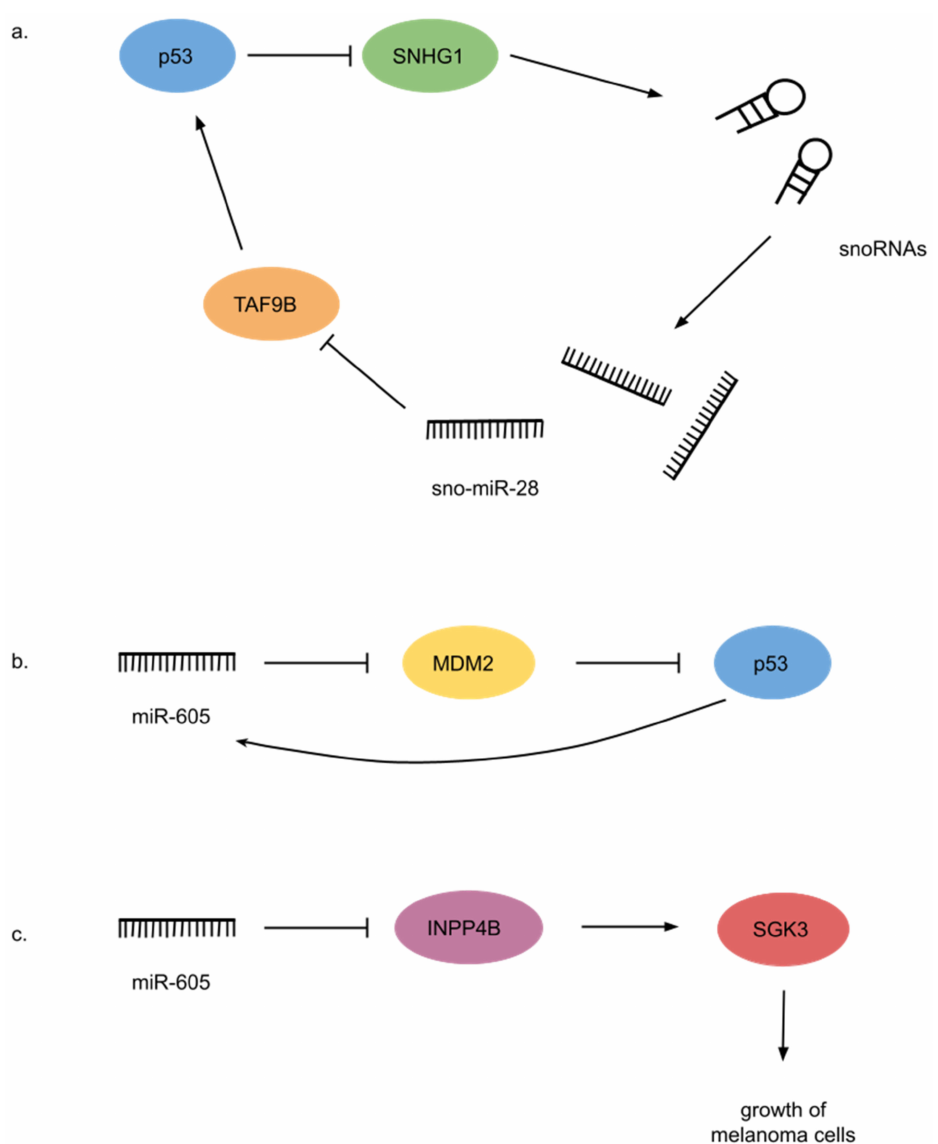
Figure 4. sdRNA mode of action. ( a ) p53 inhibits sno-miR-28 formation via repressing SNGH1 . sno-miR-28 targets TAF9B to negatively regulate p53 stability. ( b ) Positive feedback loop involving miR-605, MDM2 and p53. ( c ) miR-605 represses INPP4B, and consequently SGK3, which is responsible for promoting the growth of melanoma